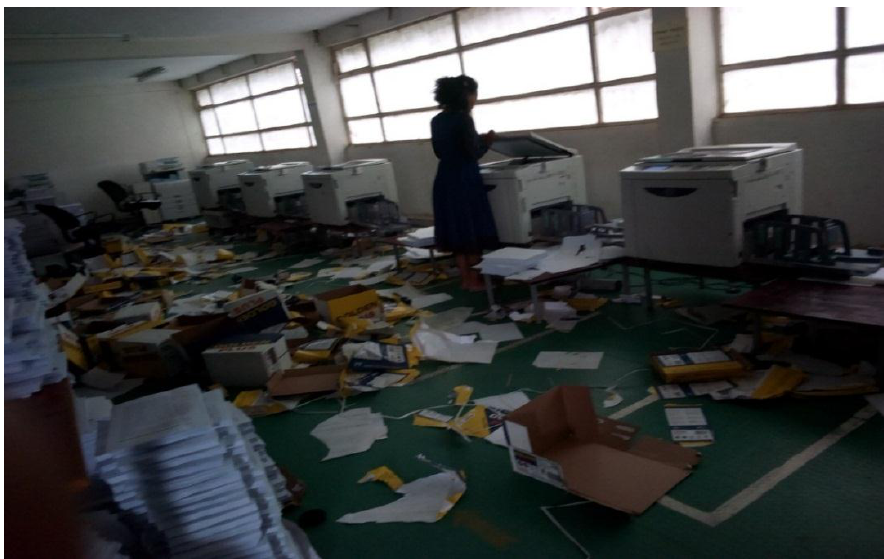
Figure 1. Woldia University copy center in Woldia